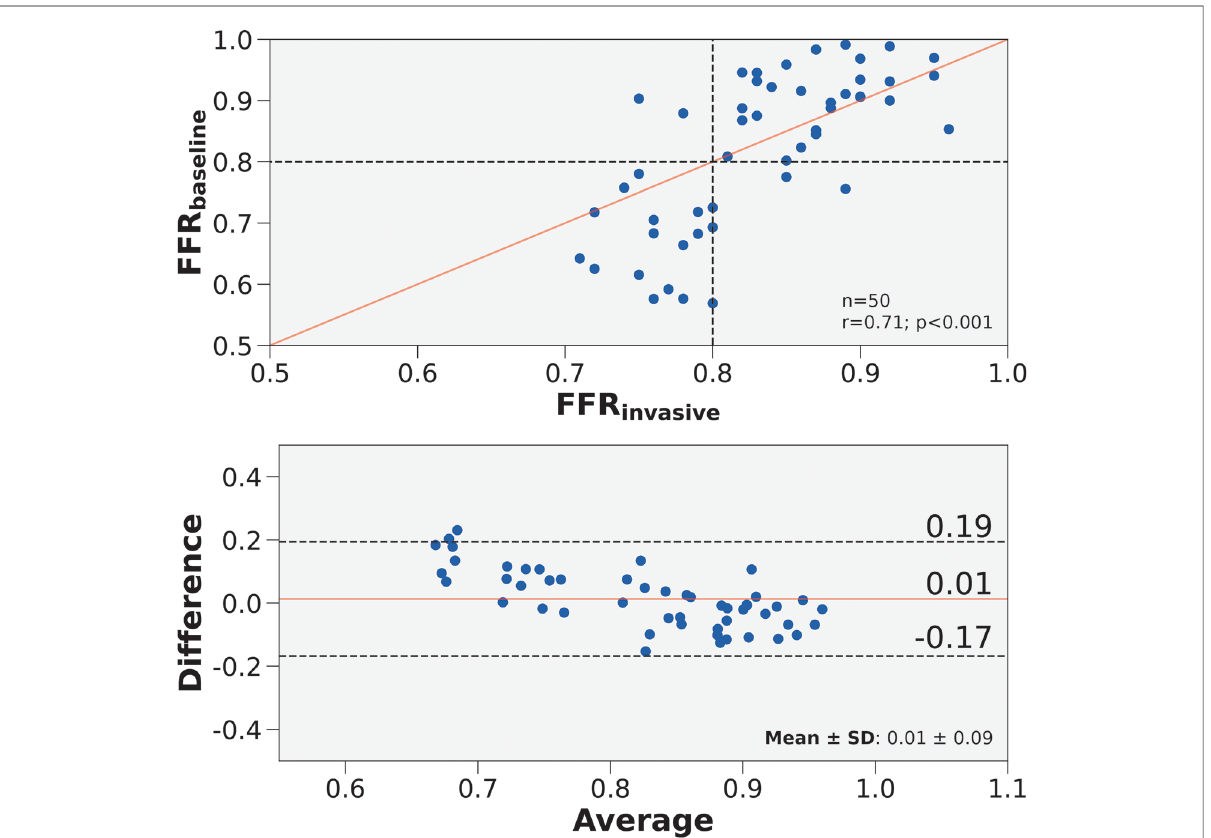
FIGURE 3 Correlation and agreement of FFR baseline compared to FFR invasive . (Top) Scatter plot of FFR baseline and FFR invasive for 50 vessels. The number of stenoses and Pearson ’ s r are presented in the lower right hand corner. Interrupted lines represent the 0.80 ischemic threshold and the solid red line represents ideal correlation. (Bottom) Bland-Altman plot displaying the mean difference between FFR baseline and FFR invasive for 50 vessels. The mean difference and standard deviation are presented in the lower right corner. Black interrupted lines indicate the upper and lower limits of agreement ( s : + 1.96) and the solid red line indicates mean